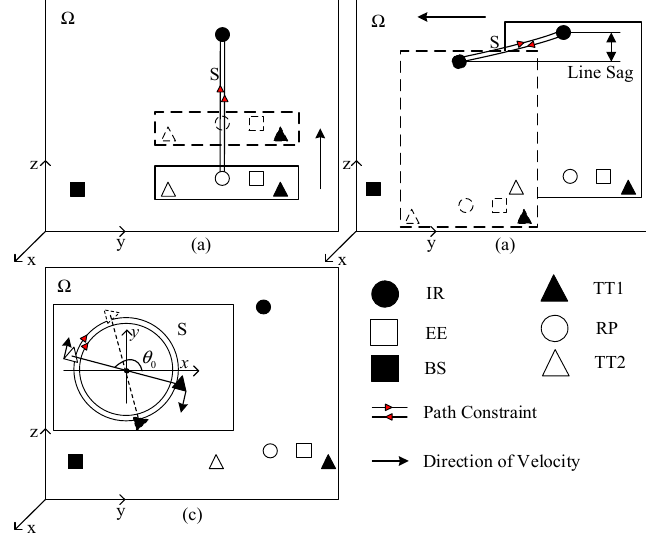
Figure 5. Movement of nodes. ( a ) Motion 1; ( b ) Motion 2; and ( c ) Motion 3.